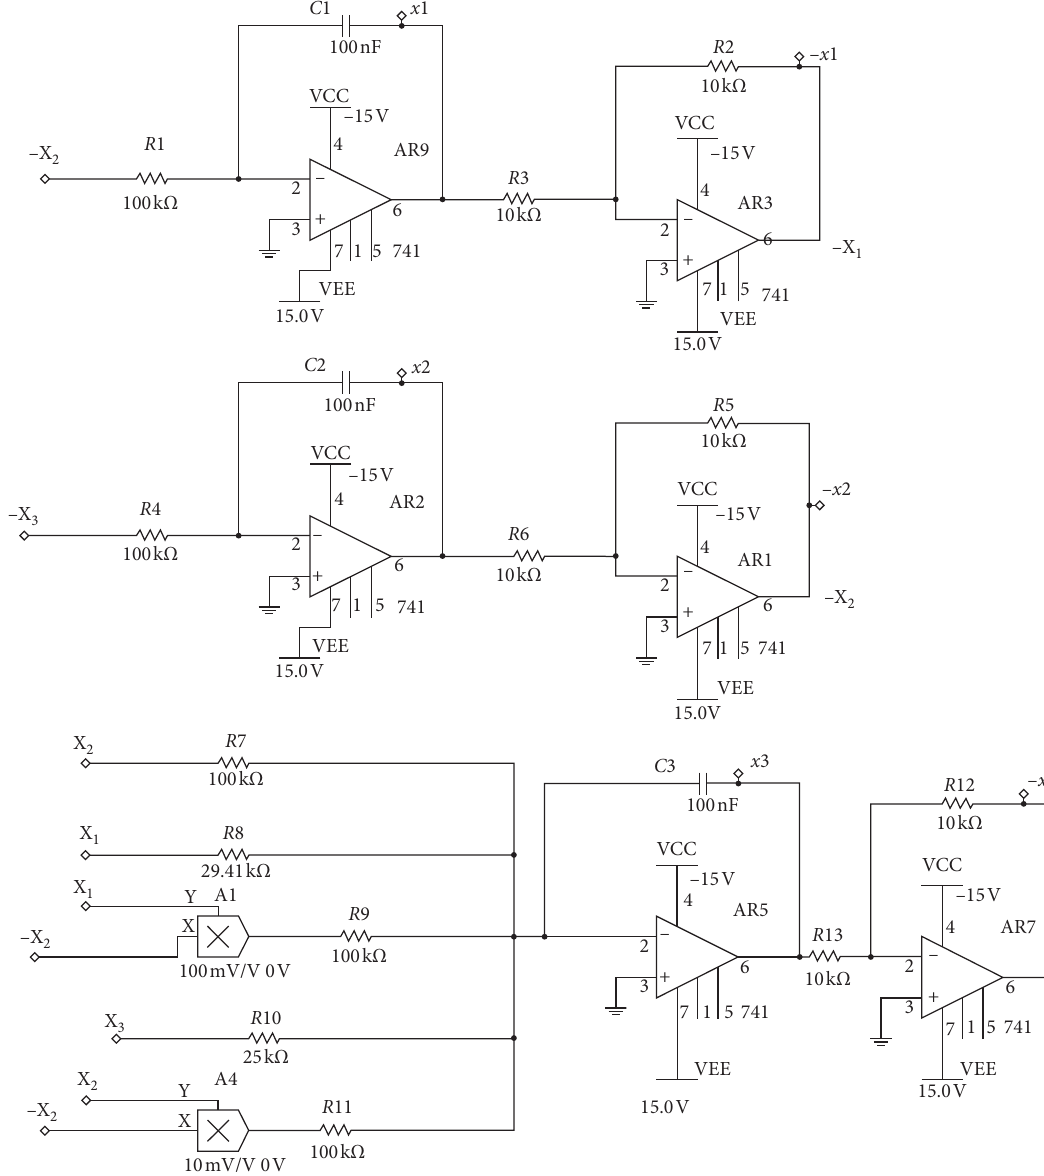
Figure 8: The circuit principle diagram of the 3D jerk system (1).